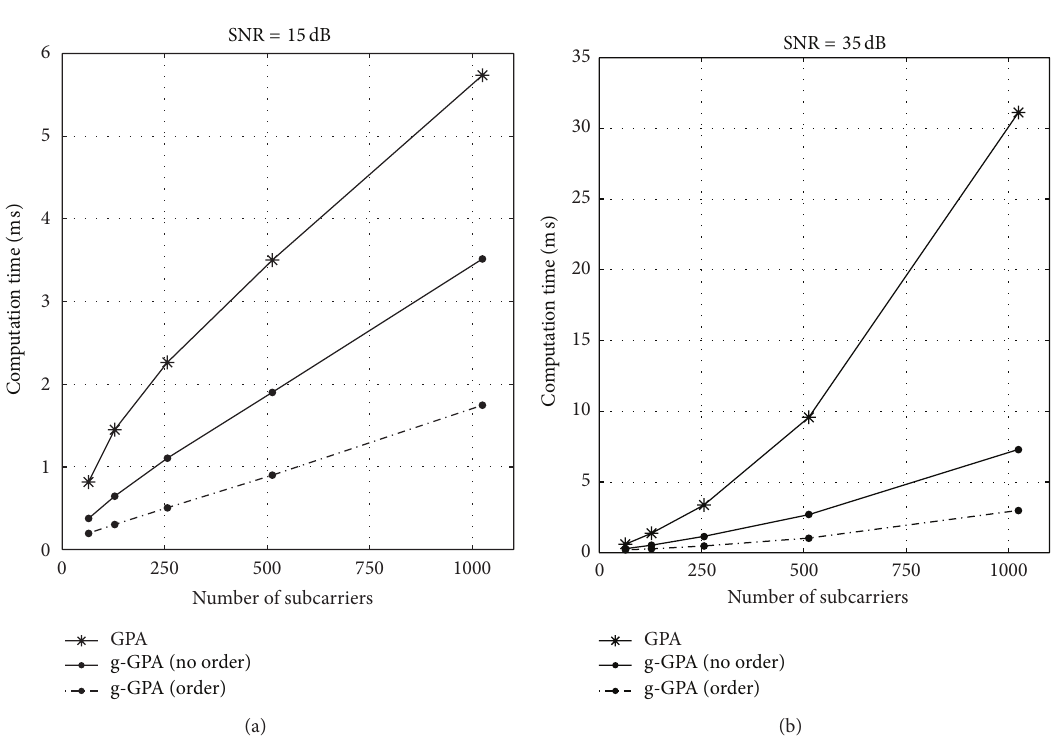
= 10 −3 and varying 𝑁 -subcarrier system b